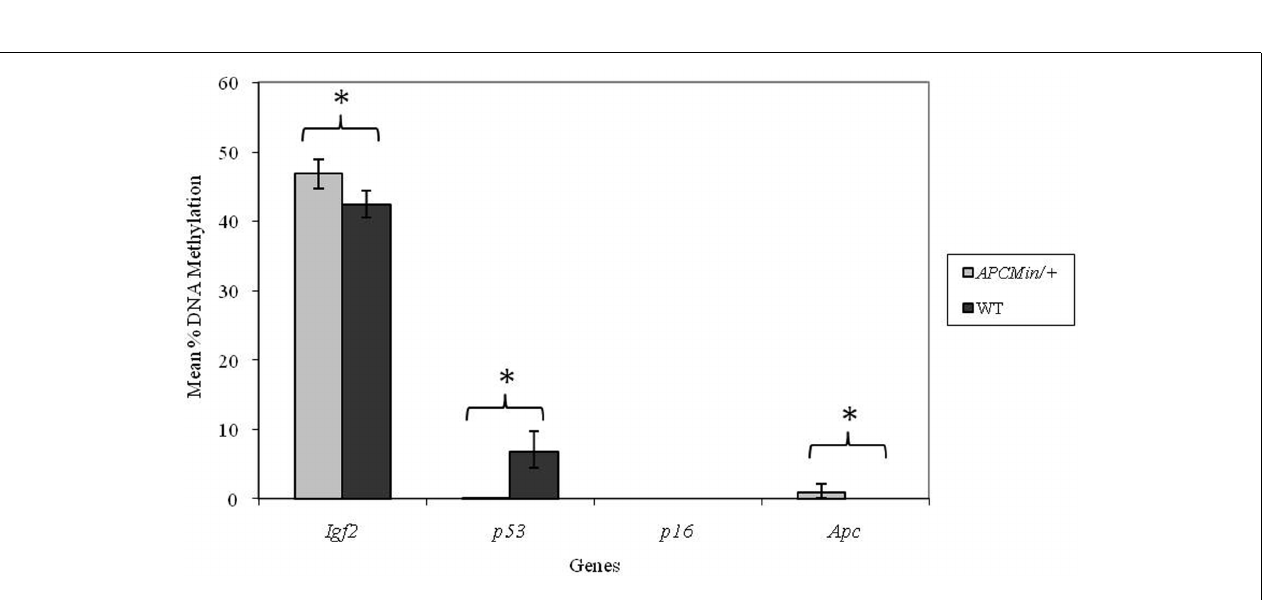
n = 20 and 20; p16 , n = 19 and 19; and Apc , n = 19 and 18 for Apc + /Min andWT mice respectively. Error bars represent 95% confidence intervals. * p <